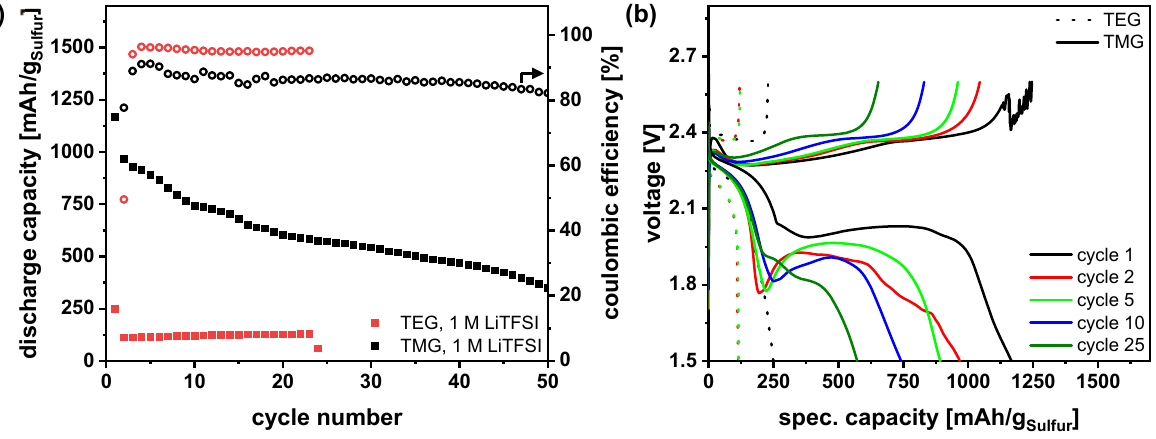
Figure 1. Galvanostatic cycling at 0.1 C and 25 °C of pure TMG and TEG-electrolyte with 1 M LiTFSI: ( a ) cycle life, ( b ) voltage profiles in coin cells.